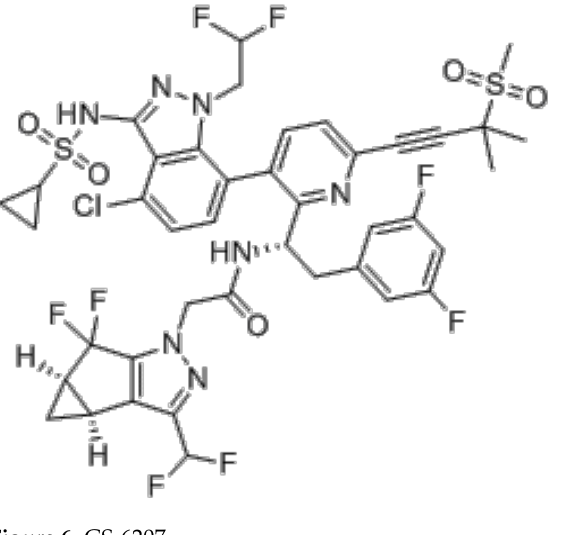
Figure 6. GS-6207. Figure 6.